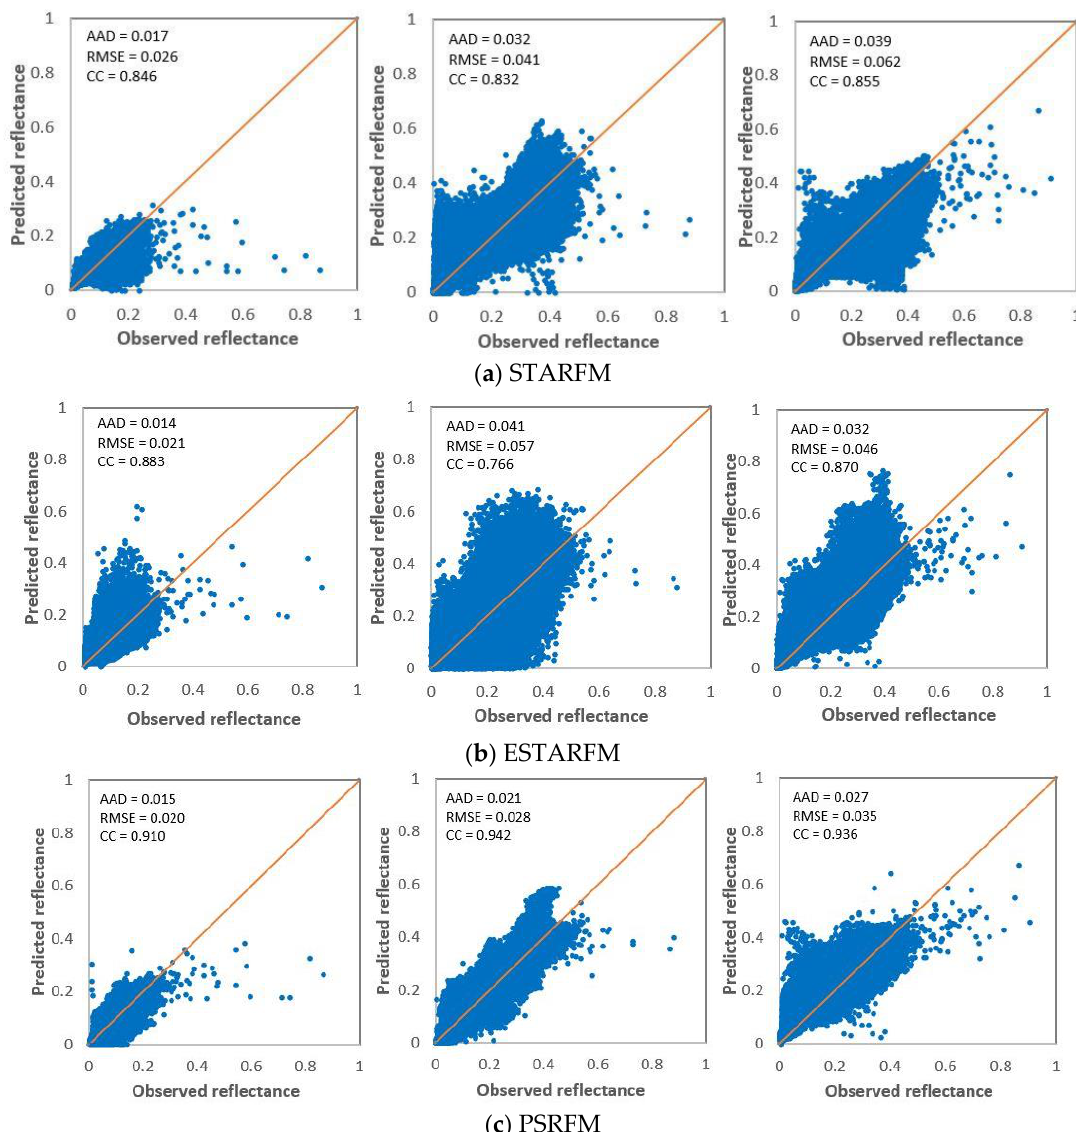
Figure 5. Scatter plots of predicted reflectance against observed reflectance using ( a ) STARFM, ( b ) ESTARFM and ( c ) PSRFM for prediction date 6 May 2016.